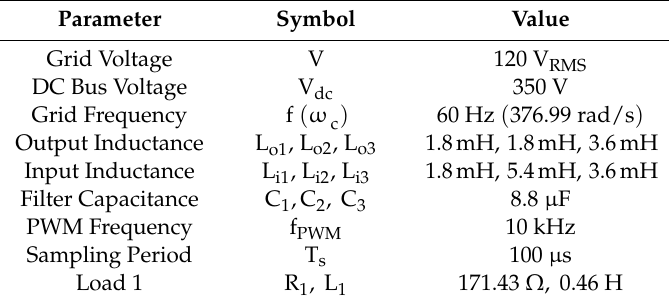
Table 1. Parameter specifications for the developed